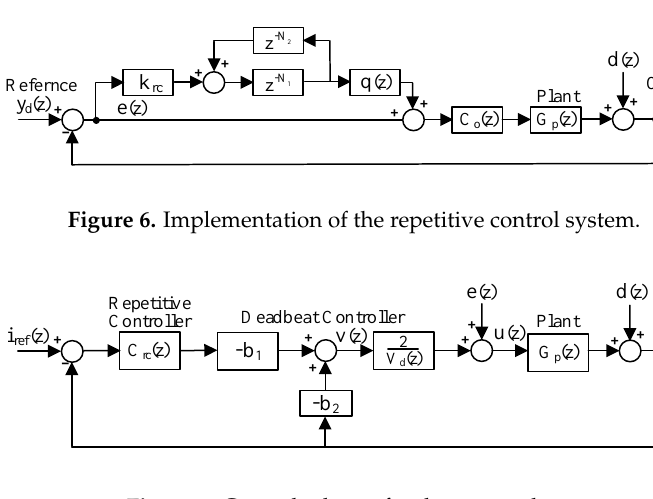
Figure 7. Control scheme for the current